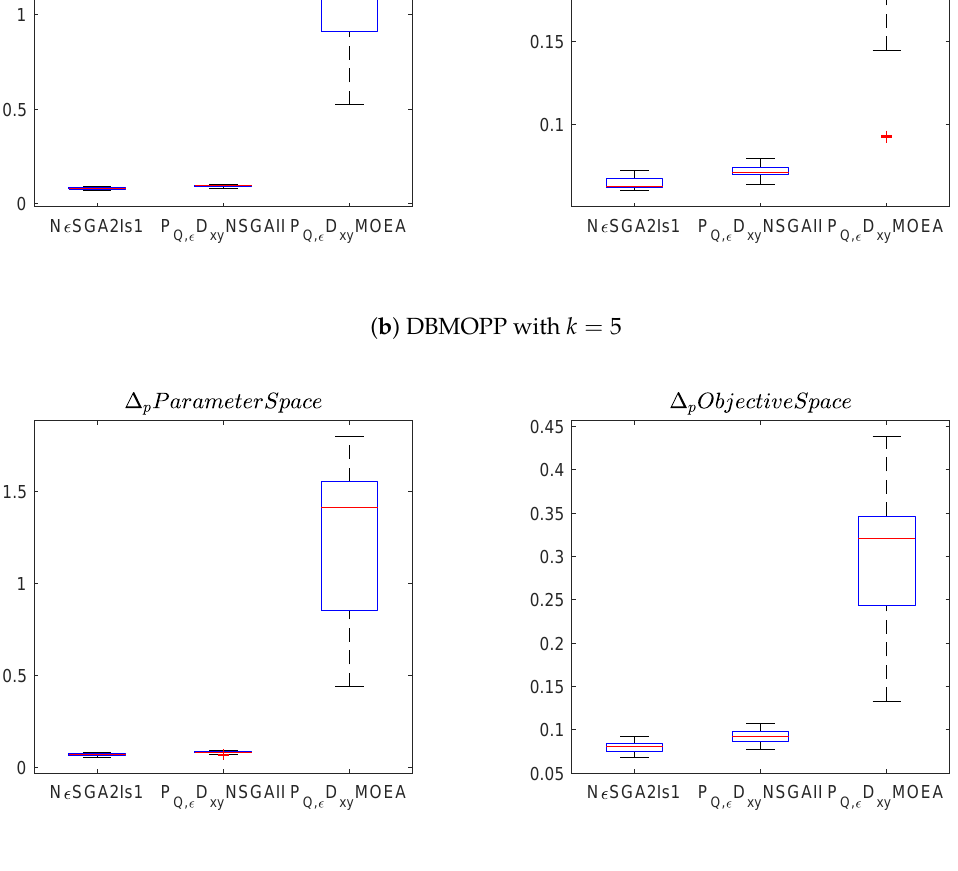
Figure 10. Box plots of ∆ 2 in decision space (left) and objective space (right) of N e SGA, P Q , e D xy -NSGA-II and P Q , e D xy -MOEA/D.